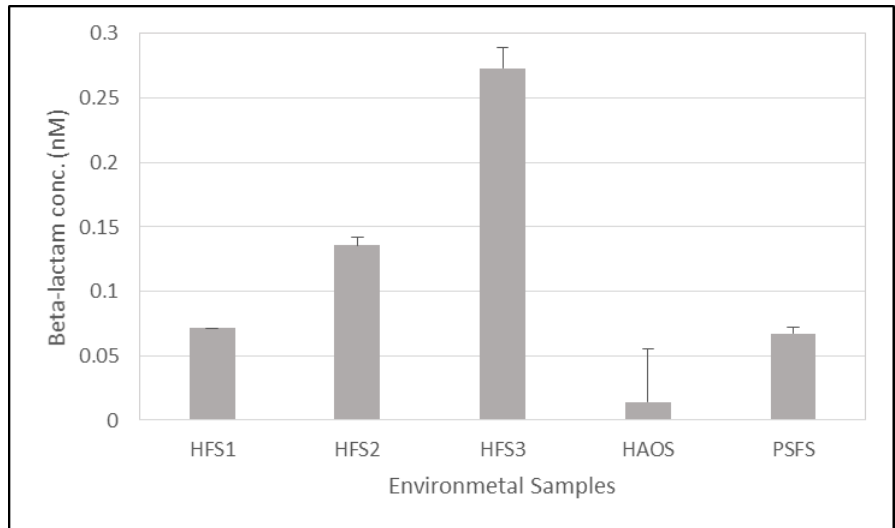
Figure 5. Quantification of penicillin G traces in five contaminated environmental samples (floor smear) including the clinic general entrance (HFS1), intensive care (HFS2), daily drug distribution and patient treatment room (HSF3), hospital administration o ffi ce (HAOS), and the pharmaceutical storage of the clinic (PSFS).